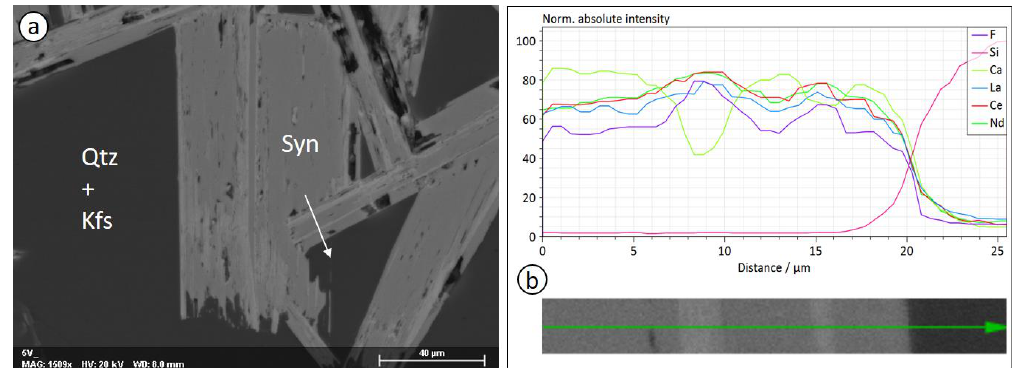
Figure 6. ( a ) SEM-BSE image of fluorcarbonates from Cinquevalli showing elongated crystals of synchysite-(Ce), embedded in quartz (dark gray), with brighter lamellae parallel to the elongation of the crystals near the borders or filling cavities. ( b ) Line profile along the trace evidenced in ( a ) crossing two bright lamellae. Note the mutual decrease of Ca and increase of REEs as well as F in the brighter lamellae. Because the spatial resolution of the EDS is larger than the thickness of the lamellae, the EDS spectra of the latter contain always contribution of the surrounding matrix richer in Ca. The thinner the lamella, the higher the matrix contribution, which may explain the higher Ca / REE ratio observed in the thinner lamella. Table 2. Composition of (Ca,REE)-Fluorcarbonates from Cinquevalli (Trento, Italy). Atoms Calculated on the Basis of Two Cations in the Chemical Formula. Relative Error in Brackets (Values in Italics when Below 2 σ